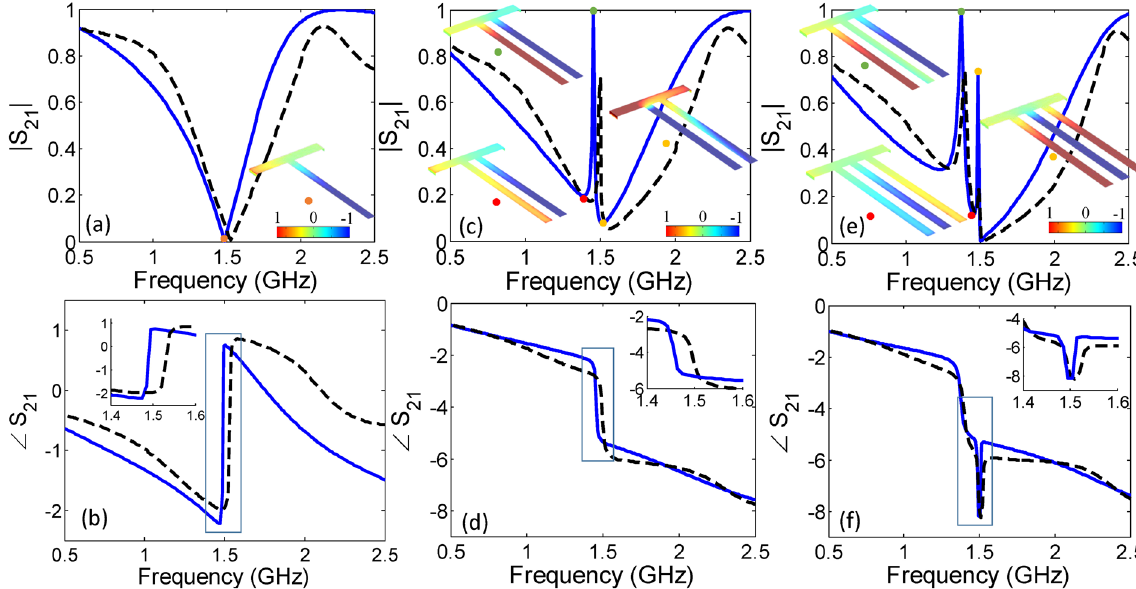
Figure 3. Transmission S 21 characteristics for magnitude and phase of the ( a , b ) single, ( c , d ) double, and ( e , f ) triple open-stub resonator. Simulated results represented in the graph as solid line and experimental results as dashed line. Inset shows surface charge distribution at the resonance point identified as a point on the graph. The surface charge distribution are normalized for negative and positive